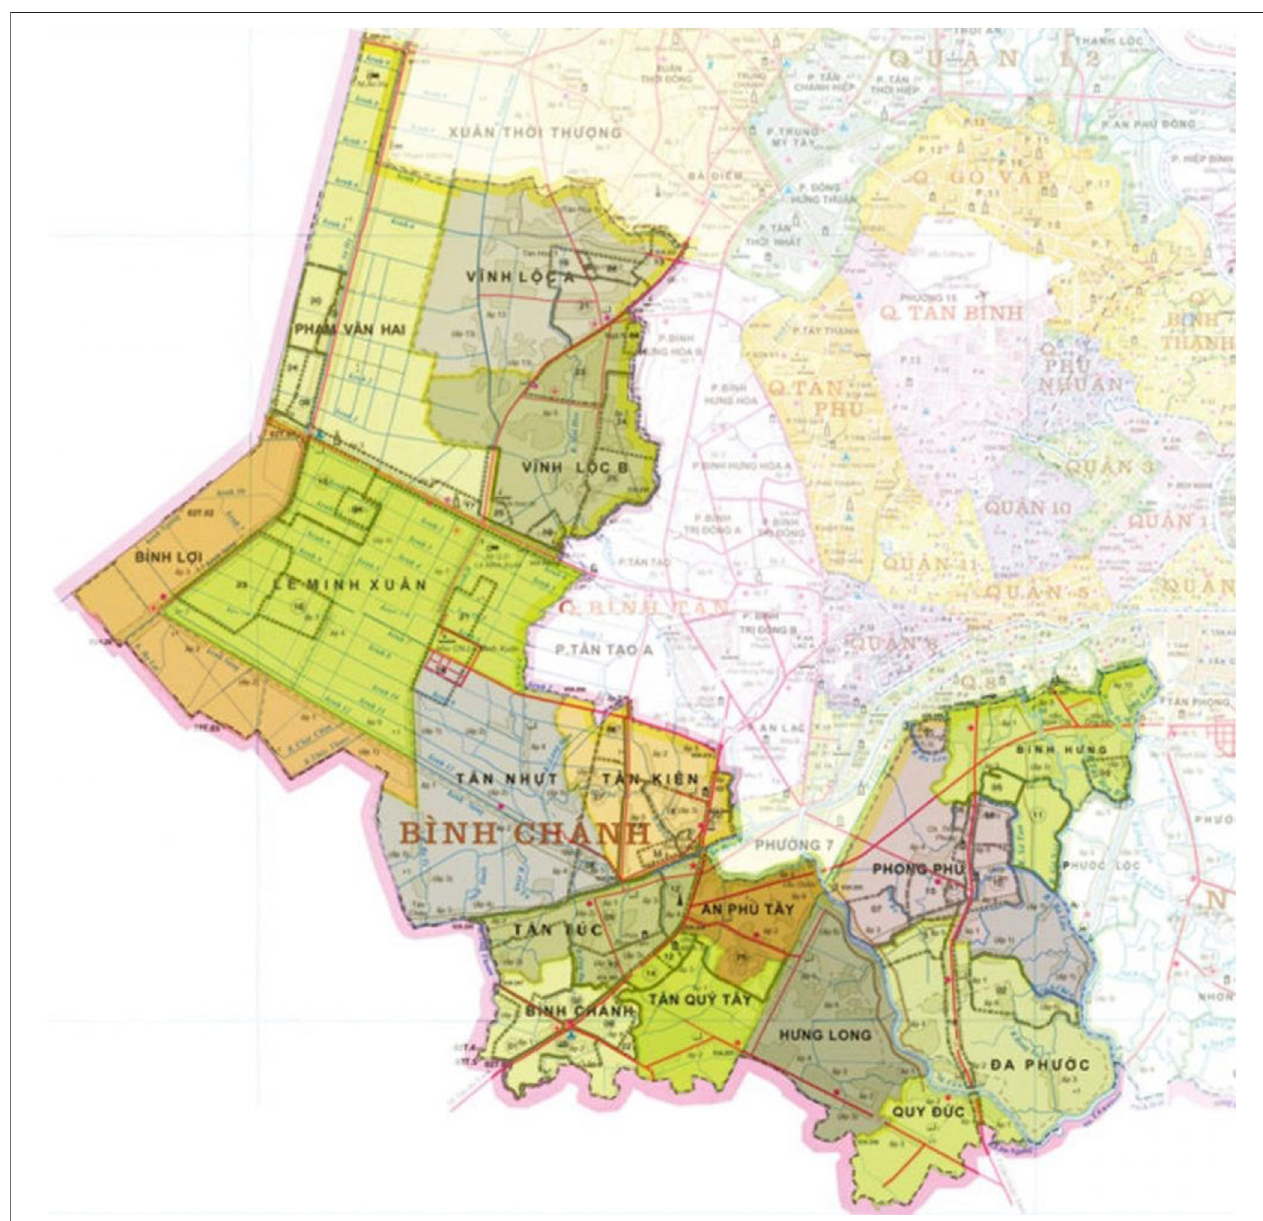
FIGURE 1 | Binh Chanh district location in Ho Chi Minh